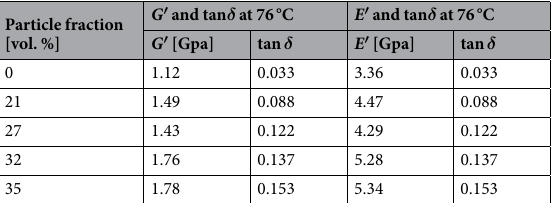
Particle fraction [vol. %]